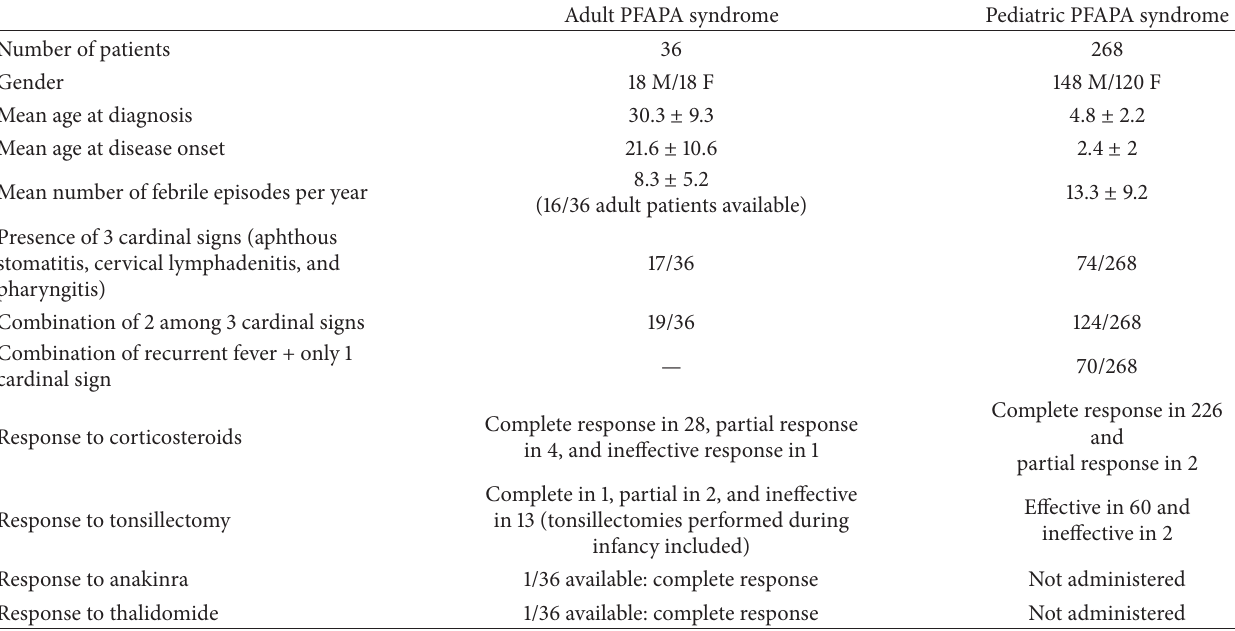
Table 1: Comparison between adult PFAPA and pediatric PFAPA syndrome regarding the main demographic and clinical characteristics and response to